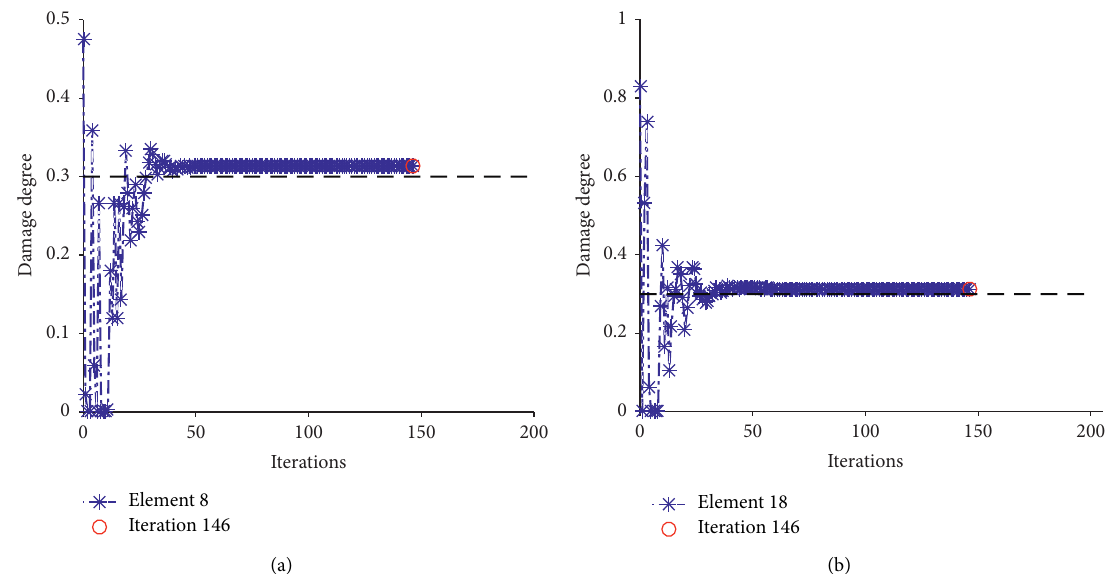
Figure 13: The reduction in stiffness calculated by IBAS (double damage case+ 0.5% for the noise level). (a) First damaged element. (b) Second damaged